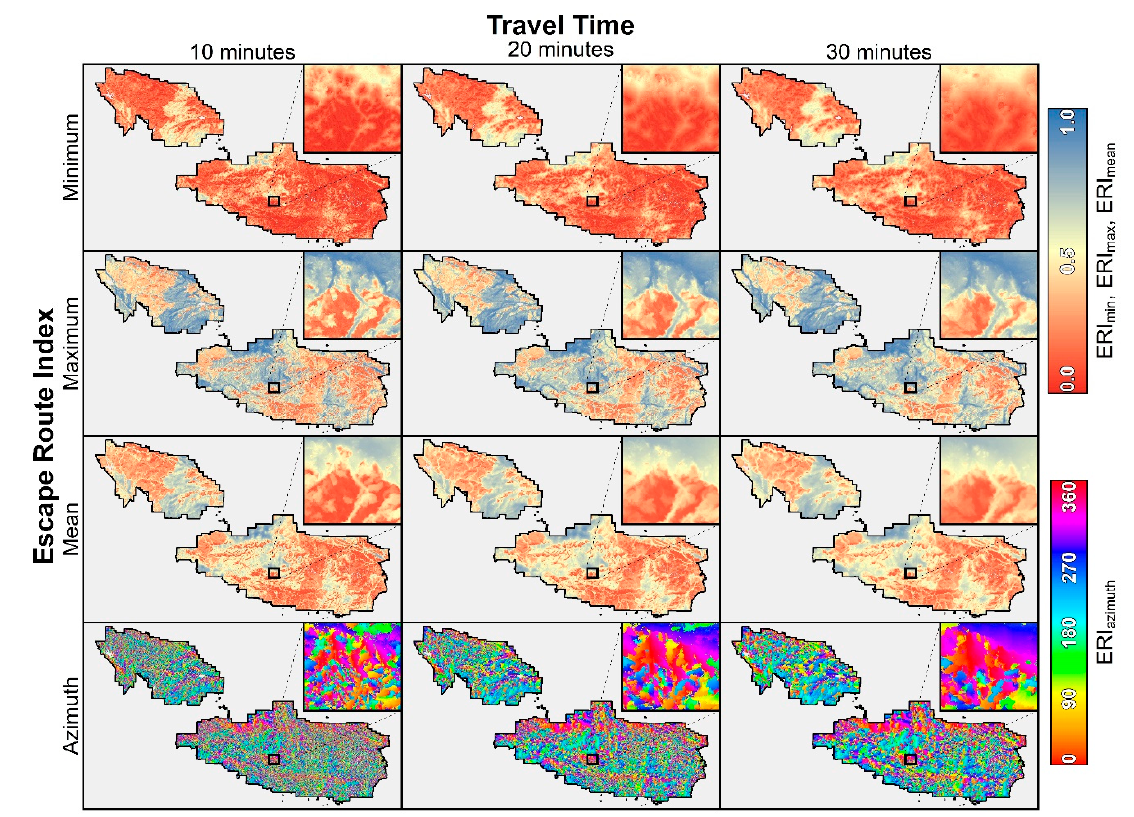
Figure 6. Results of ERI modeling for ERI min , ERI max , ERI mean , and ERI azimuth , for each of the three time frames tested (10, 20, and 30 min) throughout the entirety of the ANF.